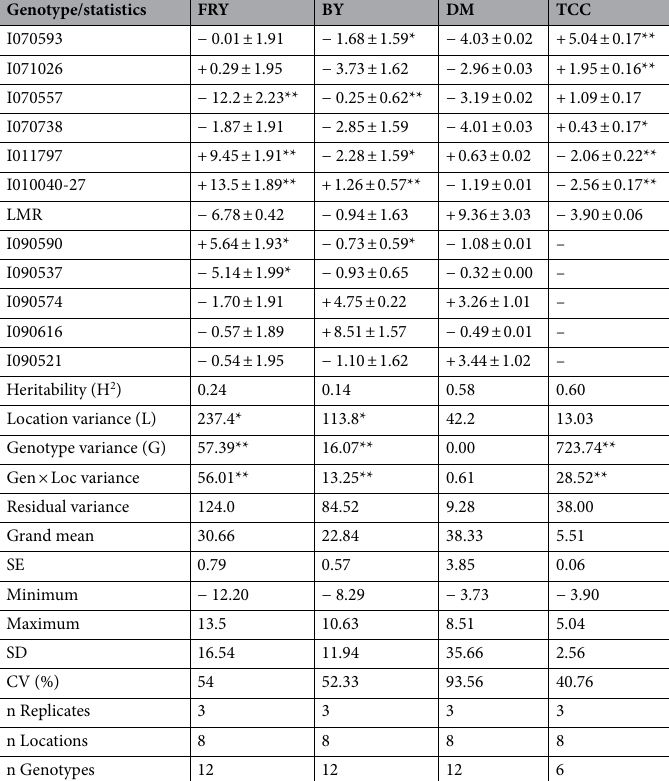
Table 3. Best linear unbiased predictors (BLUPs) of breeding values with standard errors for fresh root yield (FRY), biomass yield (BY), dry matter (DM), total carotenoid content (TCC) of cassava genotypes across eight locations. * P < 0.05, ** P < 0.01. The statistics listed for every trait are broad-sense heritability, genotype variance, residual variance, grand mean, SD = Standard Deviation, the coefficient of variation (CV %)), the number of replications (n Replicates). The statistics shown are the estimates